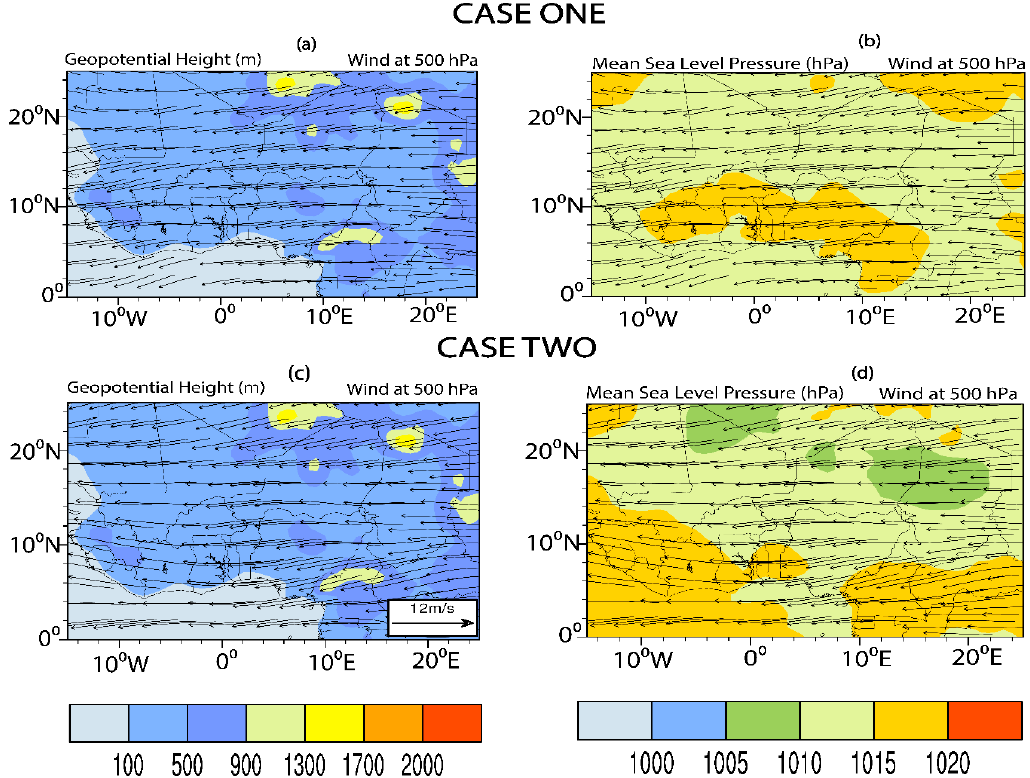
Figure 2. ( a ) Geopotential Height (m) (blue solid contour) at 850 hPa with wind speed (m/s) at 500 hPa level (overlaid) ( b ) Mean Sea Level Pressure (yellow solid contour) at 850 hPa level and wind speed (m/s) at 500 hPa level (overlaid) over the West Africa region at 06Z 28-09-2012 (CASE ONE). ( c ) Geopotential Height (m) (blue solid contour) at 850 hPa with wind speed (m/s) at 500 hPa level (overlaid) ( d ) Mean Sea Level Pressure (yellow solid contour) at 850 hPa level and wind speed (m/s) at 500 hPa level (overlaid) at 06Z 11-06-2016 (CASE TWO).